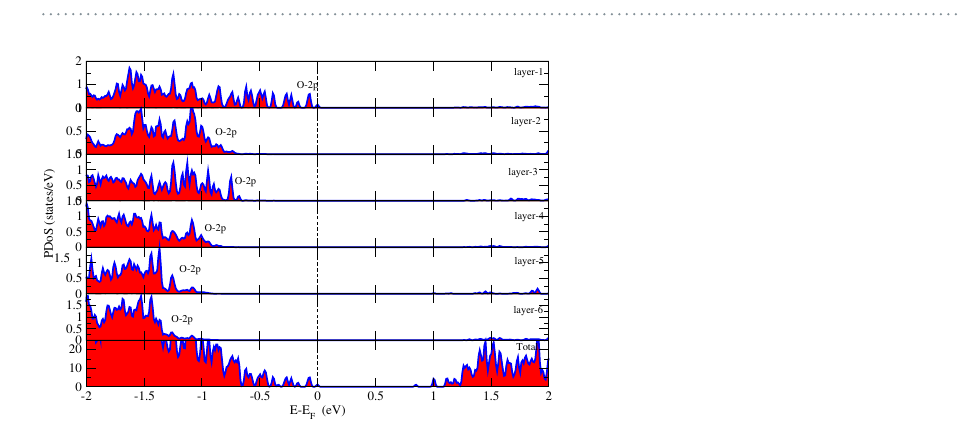
Figure 6. Partial density of states of TiO 2 terminated HS. The E f is set to zero.